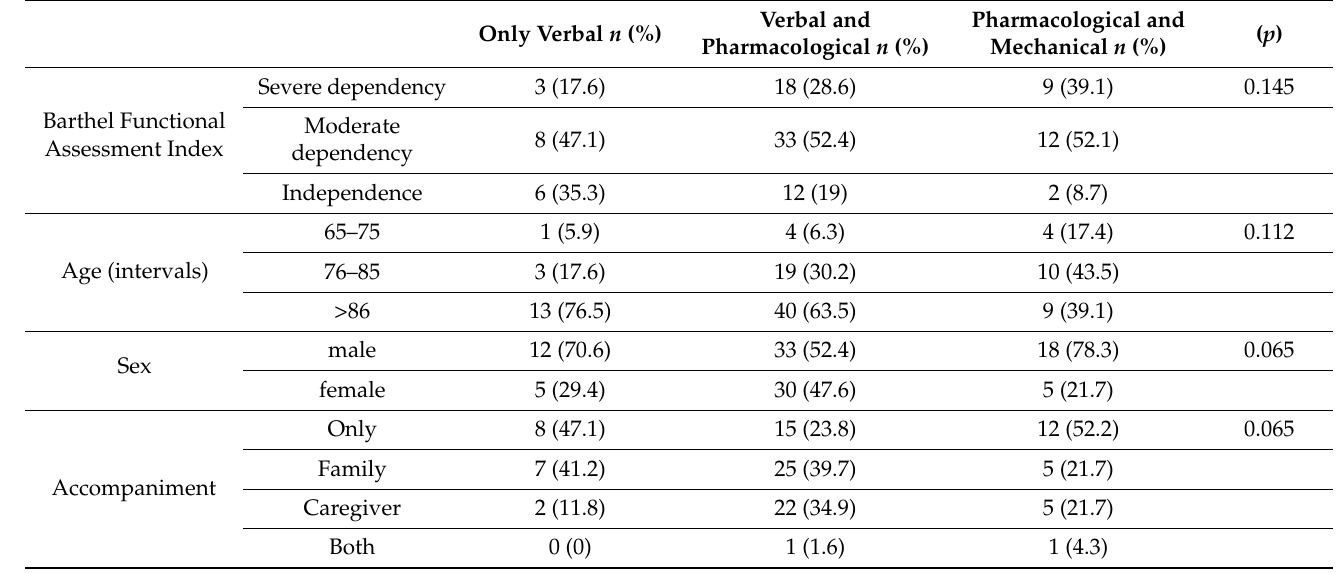
Table 4. Influence of functional and cognitive impairment, age, and sex on the type of care provided to the DAE.